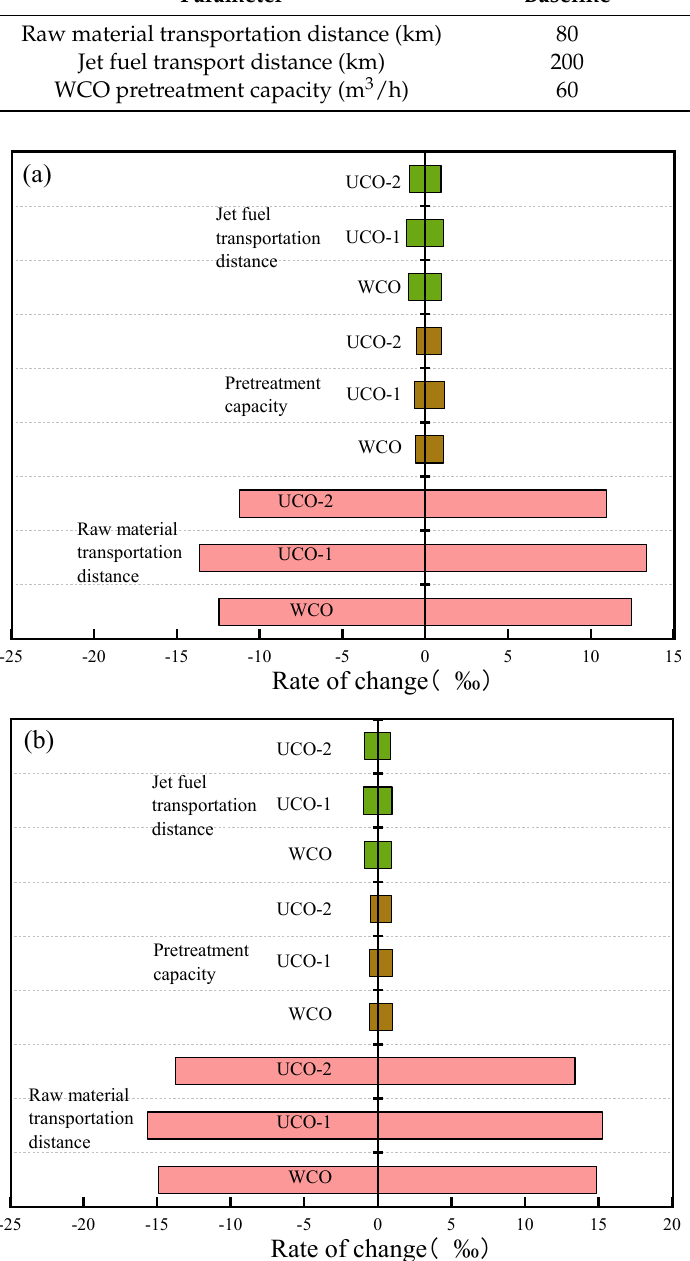
Figure 5. ( a ) The sensitivity analysis of energy consumption of bio-jet fuel. ( b ) The sensitivity analysis of life-cycle GHG emissions of bio-jet fuel.